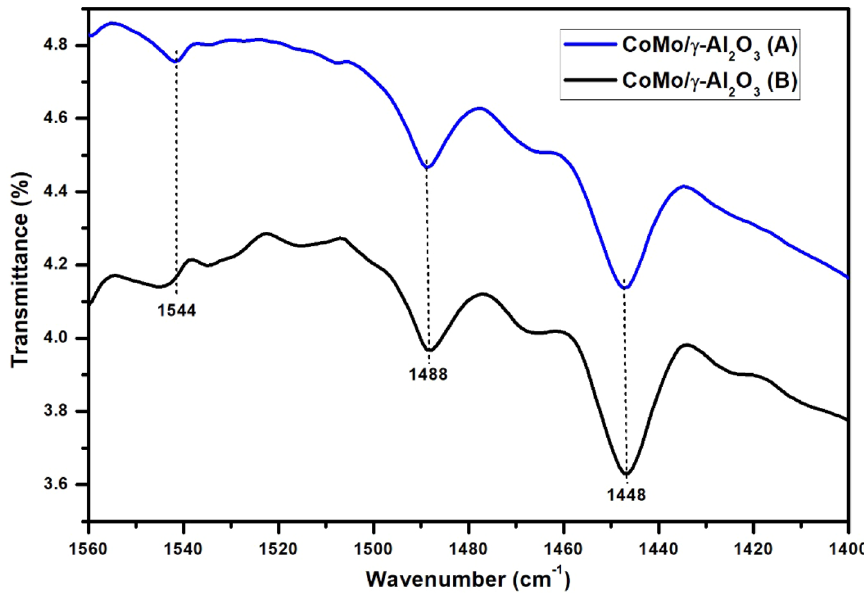
Figure 5. Pyridine IR absorption bands of CoMo/γ-Al 2 O 3 catalyst before ( A ) and after ( B ) sulphidation.